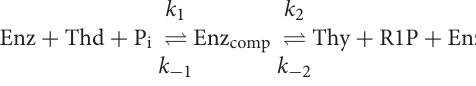
Frontiers in Bioengineering and Biotechnology |